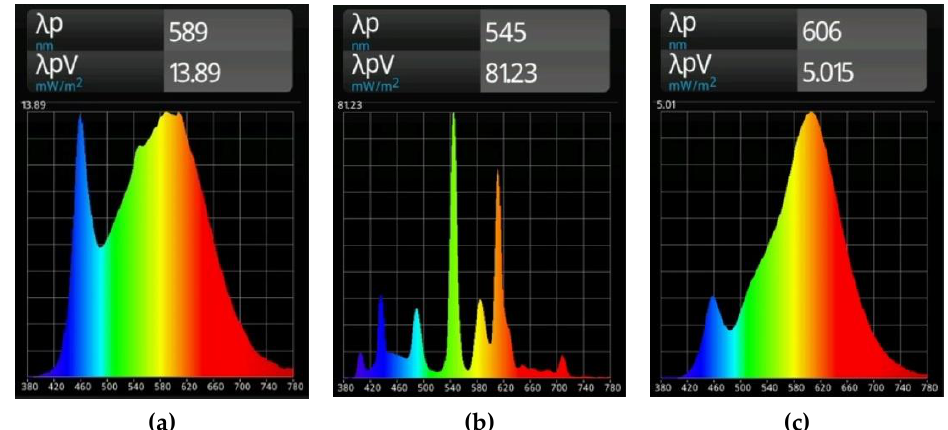
Figure 8. Comparison of spectral light distributions for the luminaires installed in room 1 ( a ); room 2 ( b ); and in room 3 ( c ). The x -axis represents the wavelength values in nanometers.